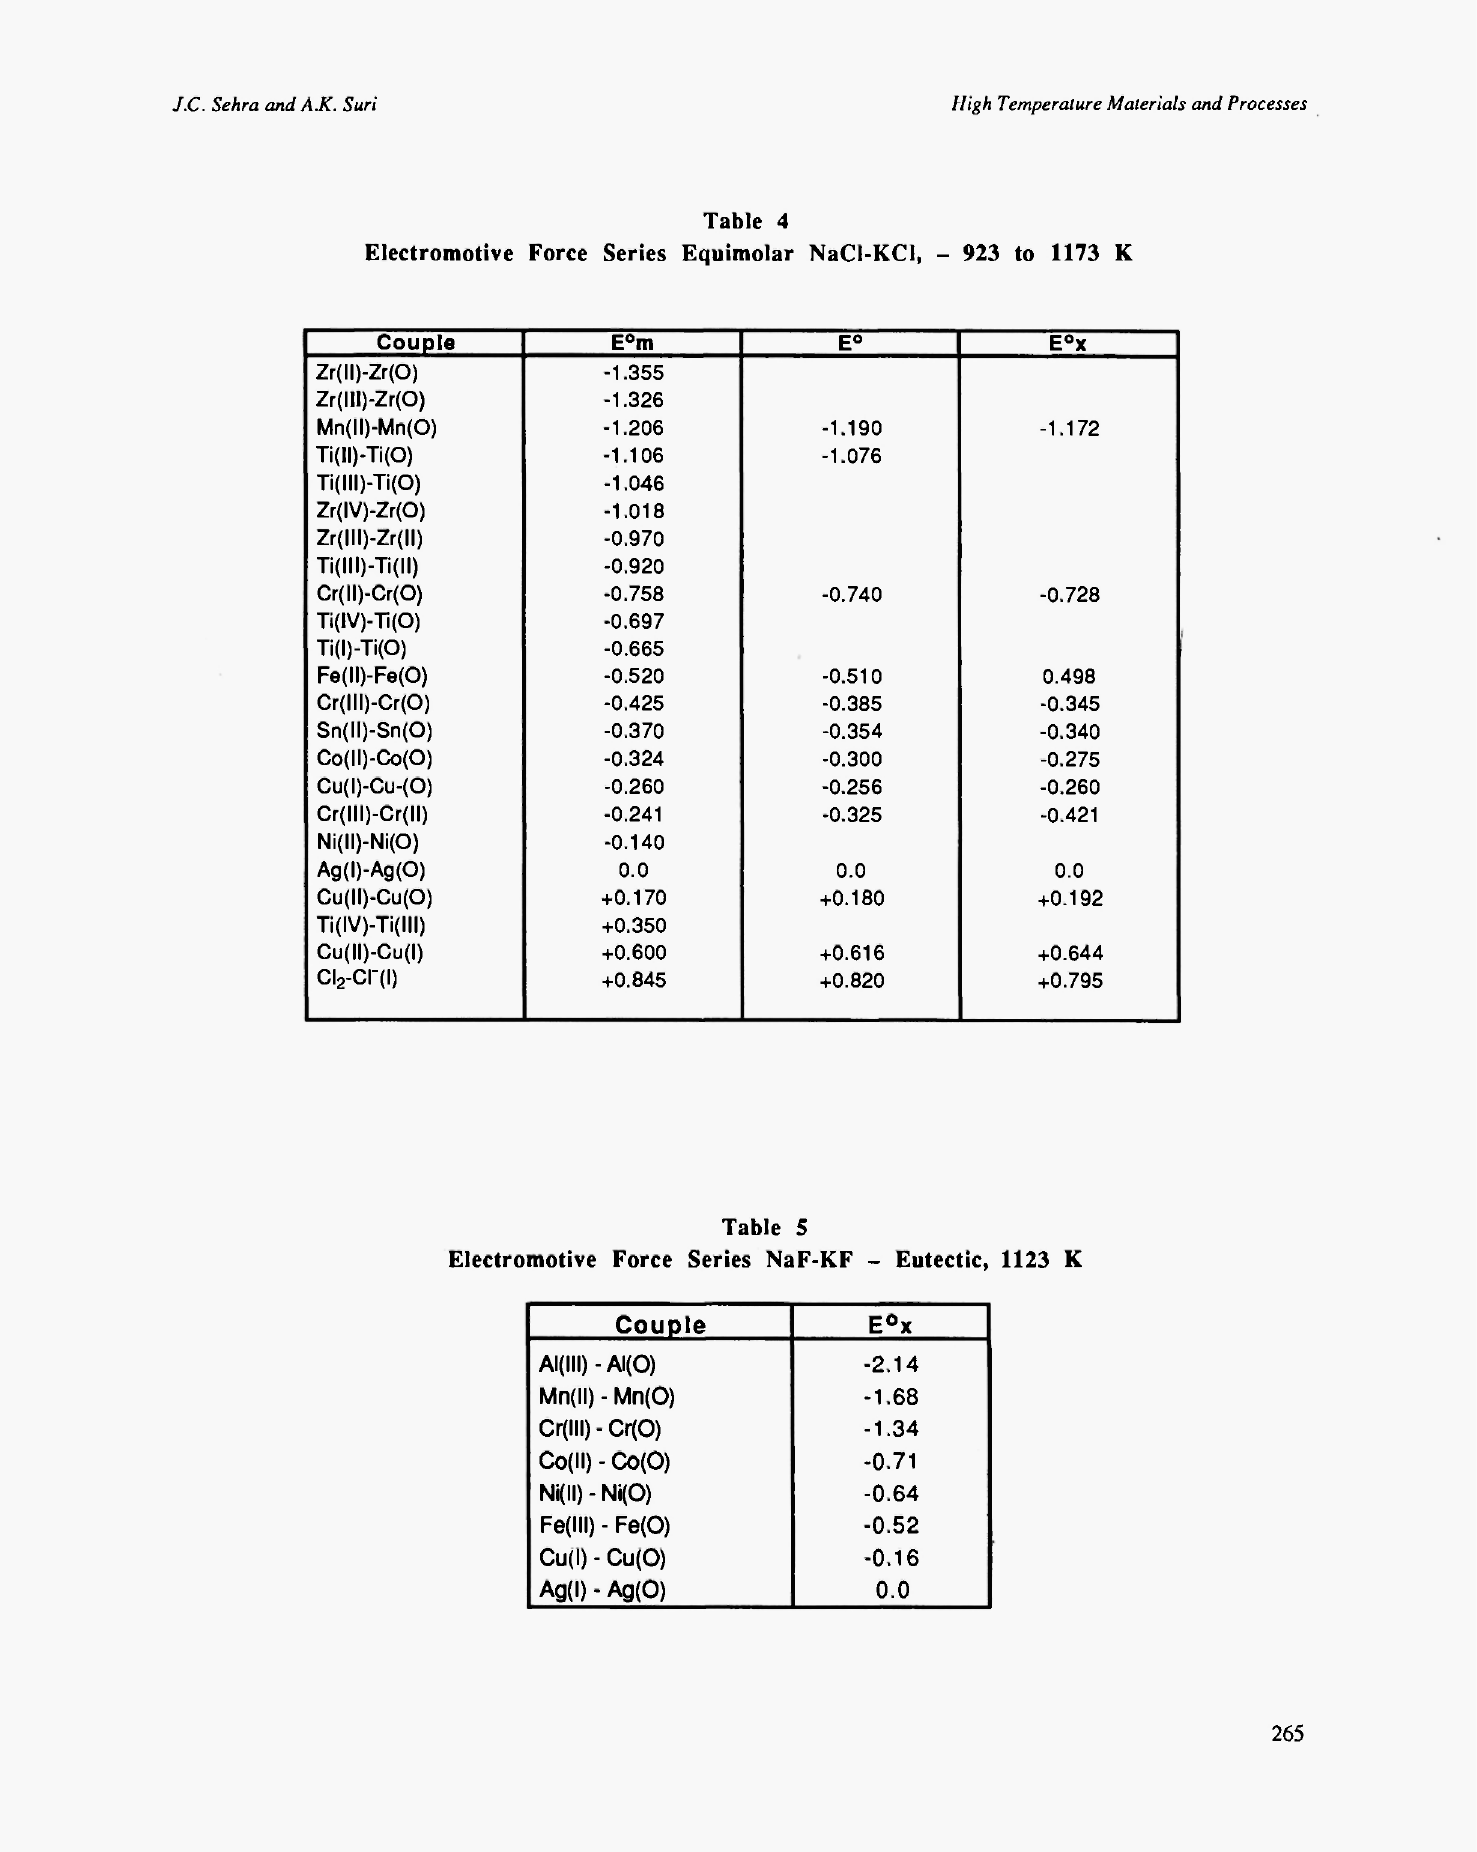
Electromotive Force Series Equimolar NaCI-KCI, - 923 to 1173 Κ